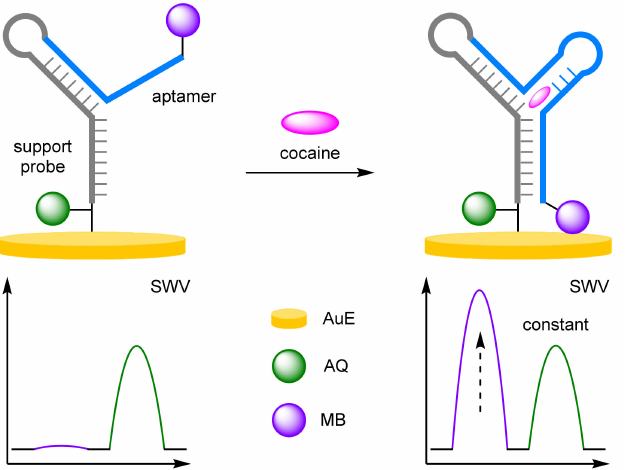
Figure 8. Schematic representation of an aptamer-based biosensor for the detection of cocaine in whole